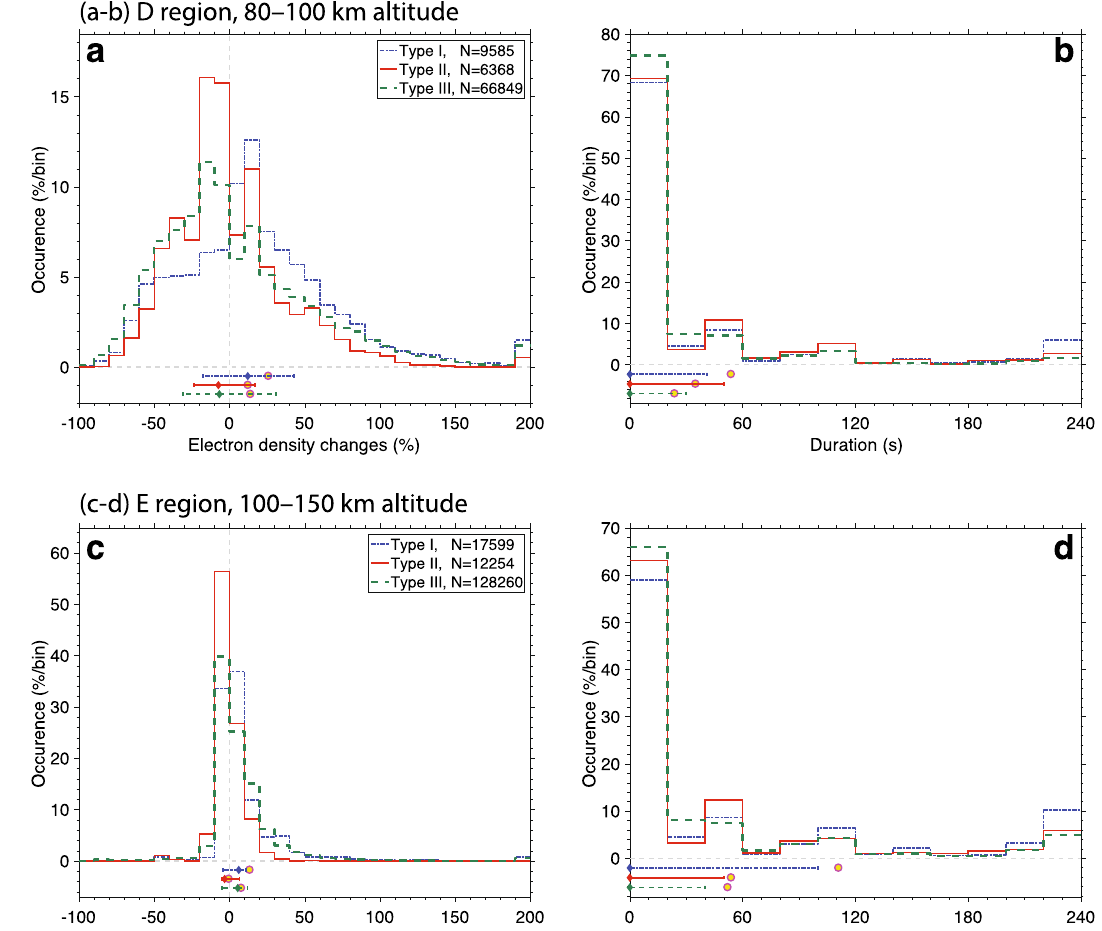
Figure 5. Statistical properties of sudden electron density changes, or spikes. Distributions of relative spike magnitudes ( a , c ) and durations ( b , d ), for two different altitude ranges, 80–100 km ( a , b ), and 100–150 km ( c , d ). The different curves in each panel show the different spike types, which are briefly defined in the bottom part of Table 1. The horizontal lines in the bottom part of each panel show the interquartile range of each data set, while the diamond and the circle show the median and average,